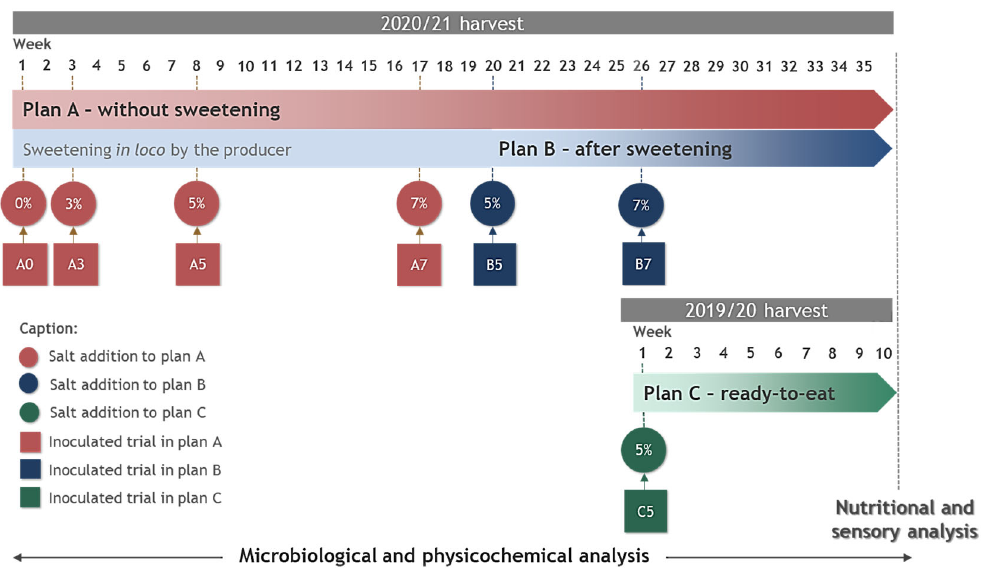
Figure 1. Scheme of experimental design followed, showing the inoculation times of Lpb. pentosus i106 under the different strategies (plans A, B, and C) and salt addition to vessels with Cobrançosa olives.